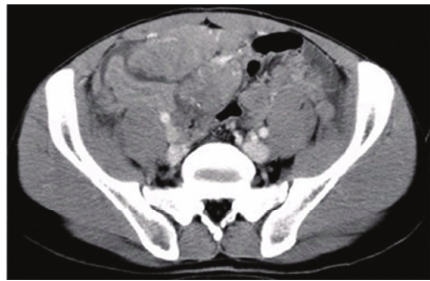
Figure 2: Contrast-enhanced CT scan revealed that most masses were slightly enhanced.